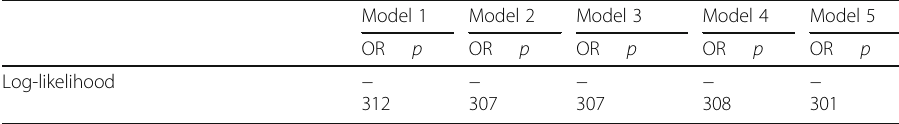
Table 4 Odds of marriage by marital intentions among cohabiting couples, stepwise logistic regressions